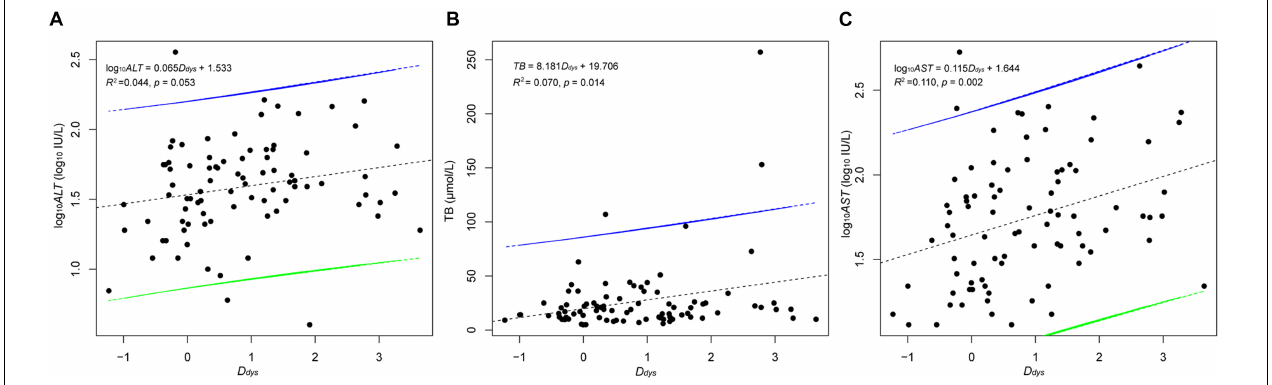
FIGURE 4 | Correlation between the D dys and the ALT level (A) , the TB (B) , and the AST (C) . The D dys was calculated based on seven probiotic bacterial genera ( Anaerostipes , Bifidobacterium , Coprococcus , Faecalibacterium , Lactobacillus , Oscillibacter , and Phascolarctobacterium ) and 13 harmful bacterial genera ( Akkermansia , Bacteroides , Clostridium , Dorea , Escherichia , Fusobacterium , Haemophilus , Helicobacter , Klebsiella , Prevotella , Ruminococcus , Streptococcus , and Veillonella ). The black dotted lines are the correlation lines. The intervals between the green and blue lines are the confidence intervals.